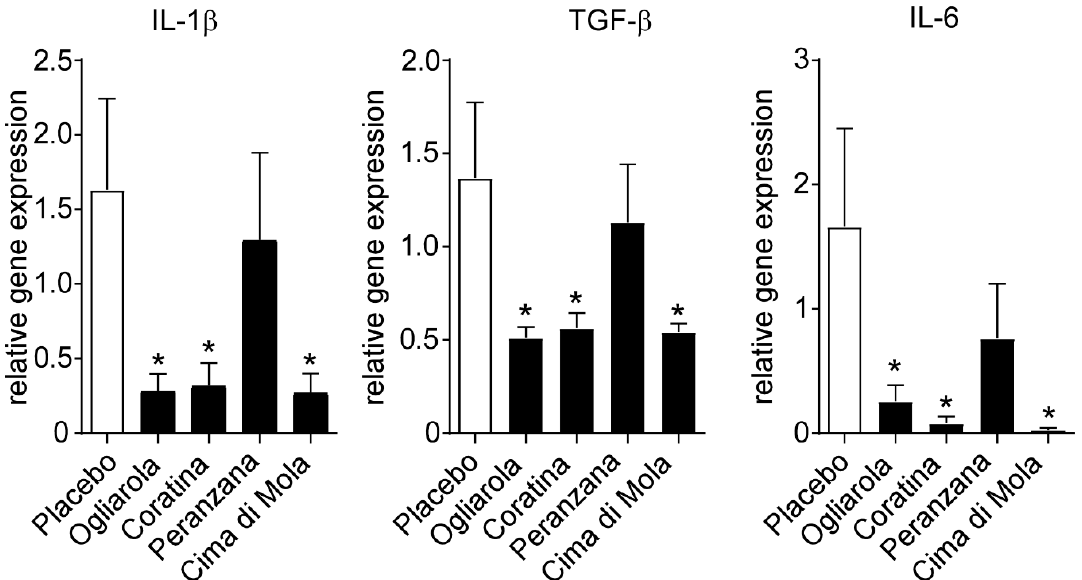
Figure 4. Apulian EVO cultivars treatment improves liver function and reduces inflammatory cytokines gene expression levels in DSS-treated mice. Gene expression analysis of colon is reported. GADPH was used as a housekeeping gene to normalize data and wild type mice as calibrators. The results are expressed as mean ± SEM. Differences between means were tested for significance using 1-way ANOVA followed by the Bonferroni test (* p < 0.05).